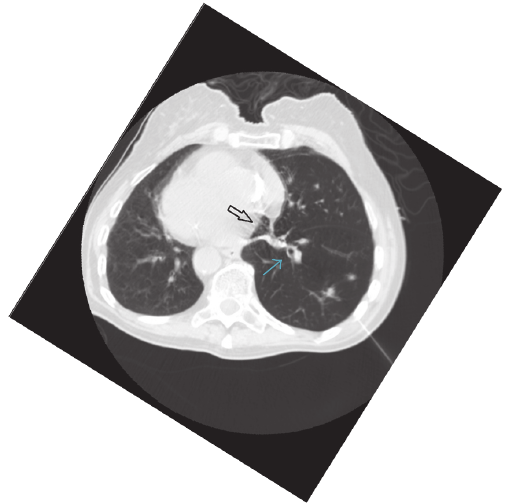
Figure 1: Arrow pointing towards collection of air in the left atrium (solid white arrow) and the right pulmonary veins (blue arrow) suggesting a Broncho venous fistula with